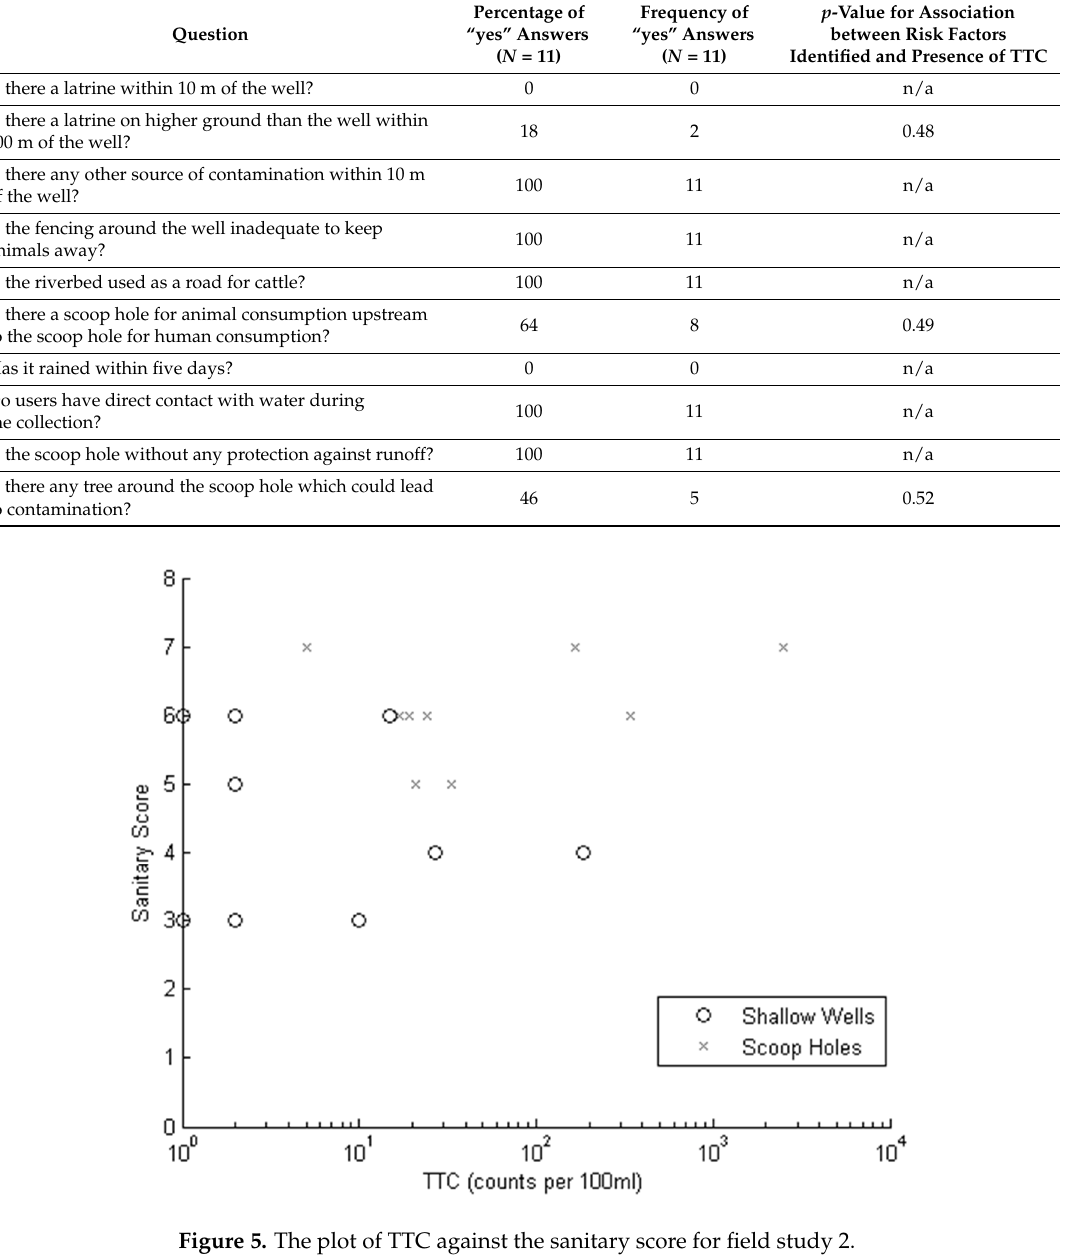
Table 4. Results of sanitary survey and Fisher’s exact test results for association between risk factors identified and presence of TTC for scoop holes for field study 2.